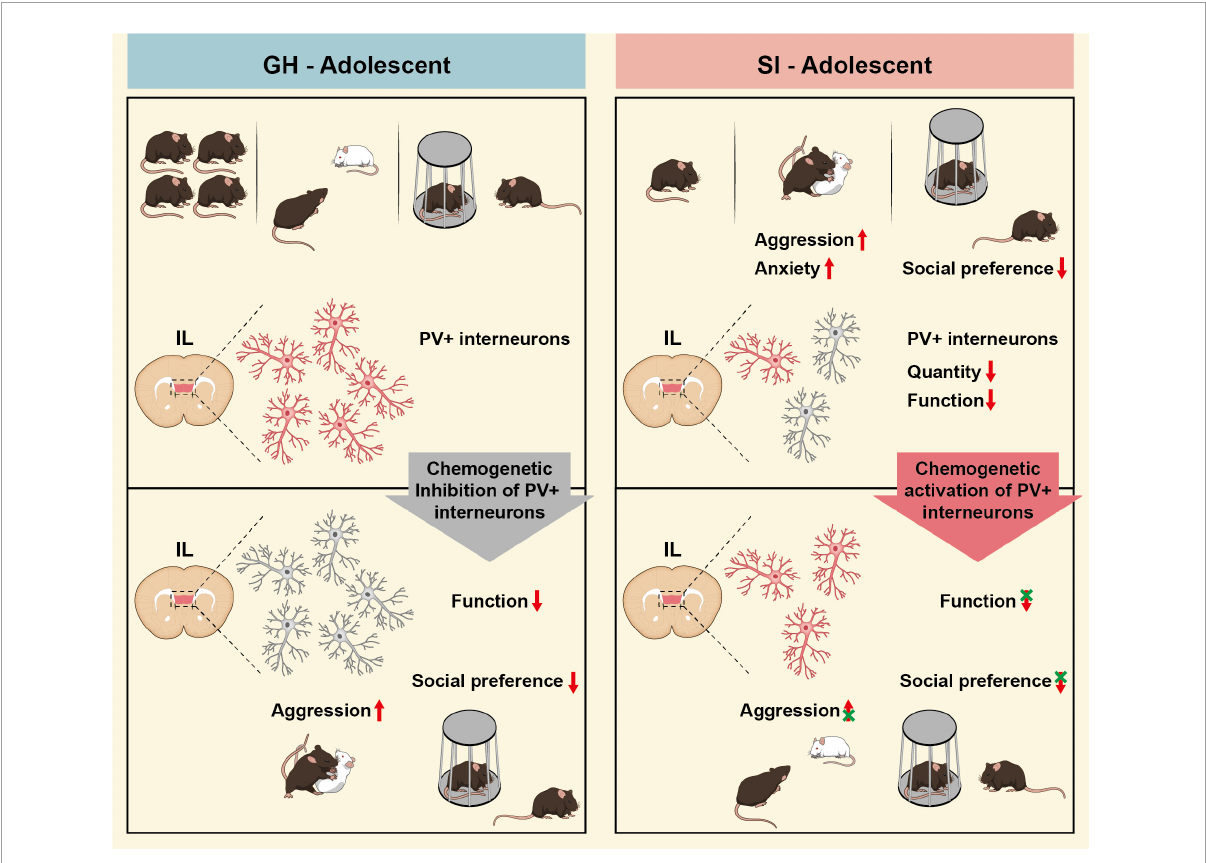
FIGURE6 A Summary scheme shows the proposed role of IL-PV + interneurons in adolescent social isolation-induced aggression. (Left panel) Adolescent GH mice exhibit typical development, including normal social behaviors and healthy IL-PV + interneurons. Increased aggression and decreased social preference can be induced in GH mice by inhibiting IL-PV + interneurons. Right panel, adolescent SI leads to excessive aggression, impaired social preference and increased anxiety compared to group housing. IL-PV + interneurons show decreases in quantity and intrinsic excitability in adolescent social isolation mice. Conversely, the excessive aggression, impaired sociability, and anxiety-like behaviors can be alleviated by activation of IL-PV + interneurons in these adolescent SI mice. GH: group-housed; SI: social